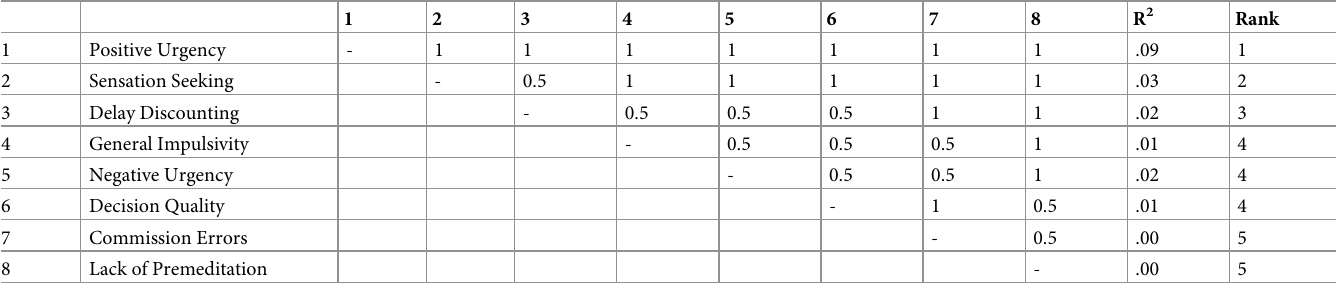
Table 6. Dominance matrix for Model 1 predicting the interpersonal facet arranged by order of complete dominance.